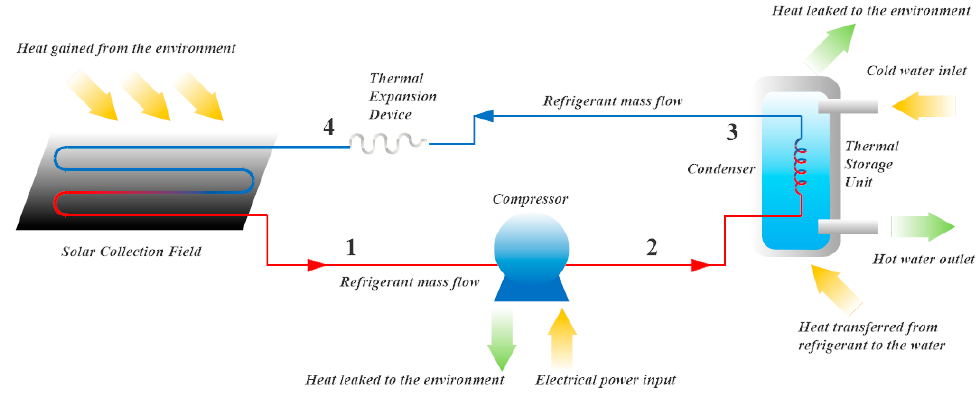
Figure 1. Energy flow diagram of the Direct Expansion Solar-Assisted Heat Pump (DXSAHP) system.